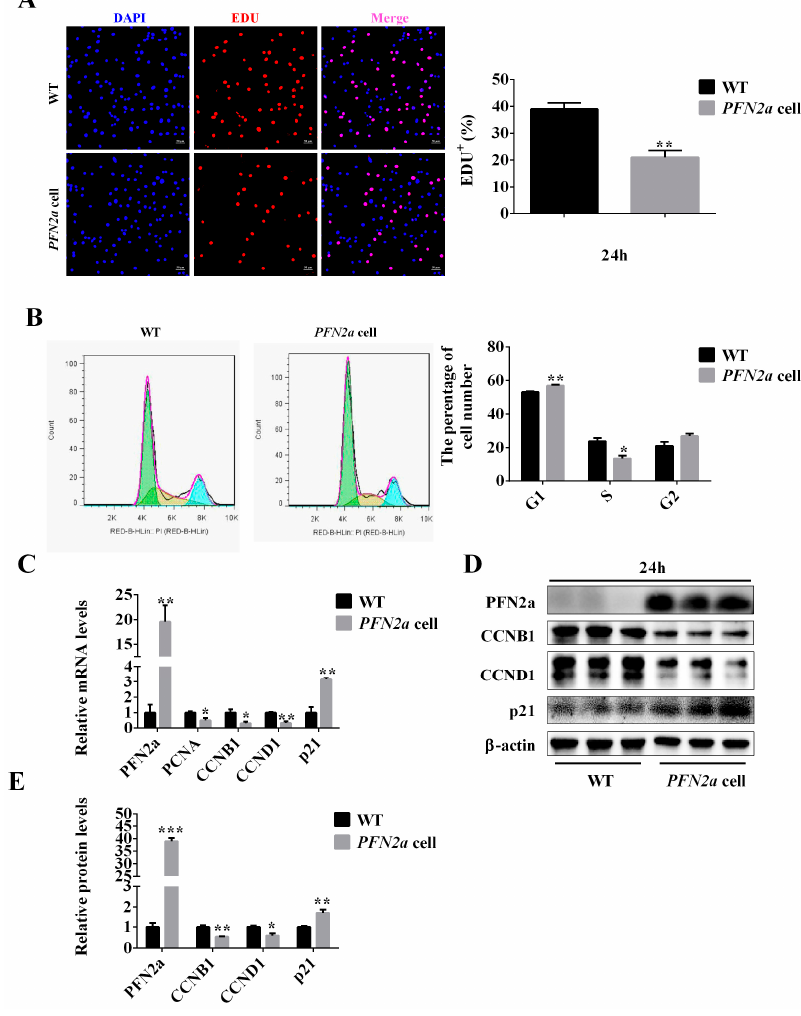
Figure 2. PFN2a overexpression inhibited C2C12 proliferation. ( A ) Representative images of the EDU staining for proliferating C2C12 are shown. The cell nucleus was stained with 4’,6-diamidino-2-phenylindole (DAPI). Proliferating C2C12 cells were labeled with 5-Ethynyl-2’-deoxyuridine (Edu) fluorescent dye (red). ( B ) The cell cycle in WT and PFN2a -overexpressing cells cultured for 24 h was analyzed by flow cytometry. The cells in the first green peak were in the G1 phase. The cells in the second yellow peak were in the S phase. The cells in the third blue peak were in the G2/M phase. ( C ) qPCR results indicated that PFN2a downregulated the mRNA level of CCNB1 , CCND1 , and PCNA , and increased the p21 mRNA level. ( D ) Western blot results showed the protein levels of cell cycle-related proteins and p21 corresponded to the qPCR results. ( E ) The relative protein levels obtained through WB band gray scanning showed that PFN2a downregulated the protein level of CCNB1 and CCND1 and upregulated the protein level of p21. *, statically significant at p < 0.05; **, statically significant at p < 0.01; ***, statically significant at p < 0.001. The results were presented as mean ± S.E.M. of three replicates for each group. The statistical significance of differences between means was assessed using unpaired Student’s t -test. Magnification was 200 × . The scale bar on the photomicrographs represents 50 µ m. WT: wild type C2C12 cells; PFN2a cells: PFN2a -overexpressing C2C12